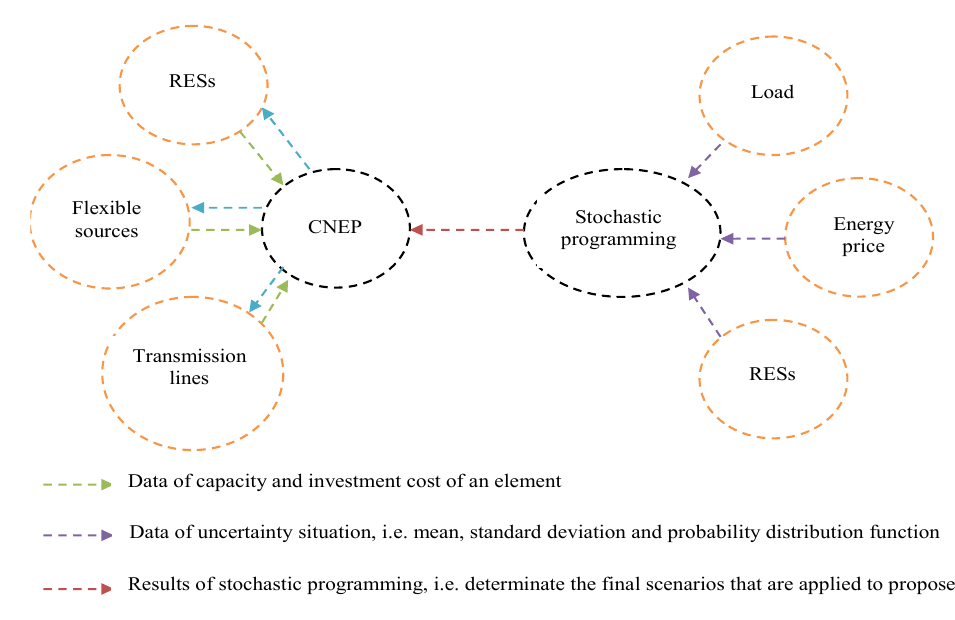
Figure 1. The outline of the proposed stochastic coordinated network expansion planning (CNEP).